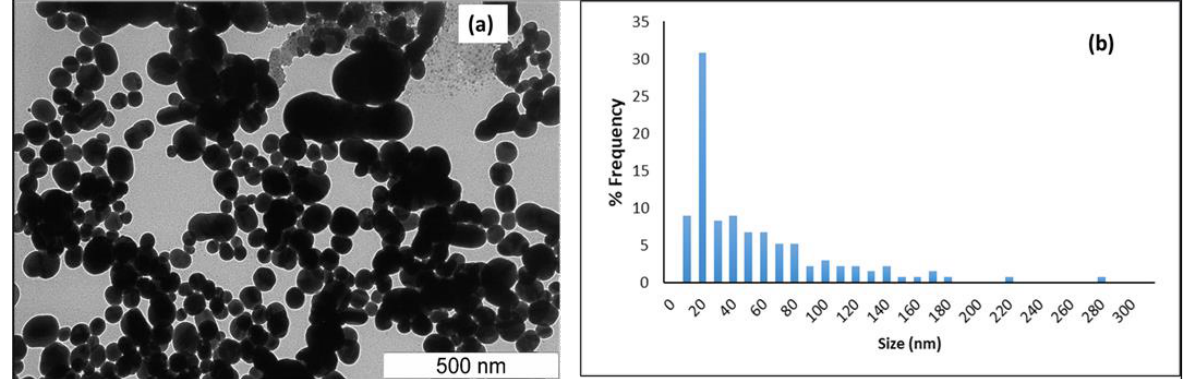
Figure 3. ( a ) TEM image of AgNPs ( b ) Histogram of Image J excel result of synthesized Ag nanoparticles.